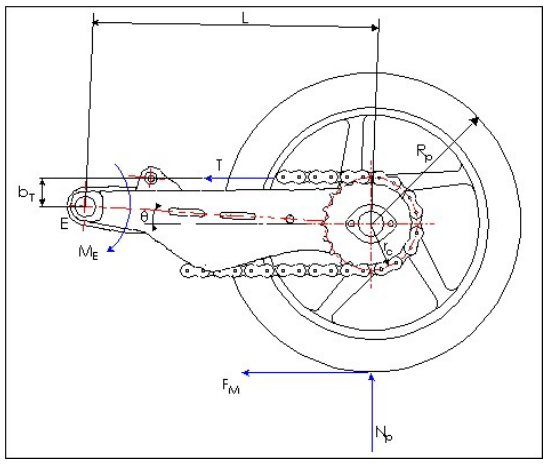
Figure 2. How chain force can affect the suspension ride response.